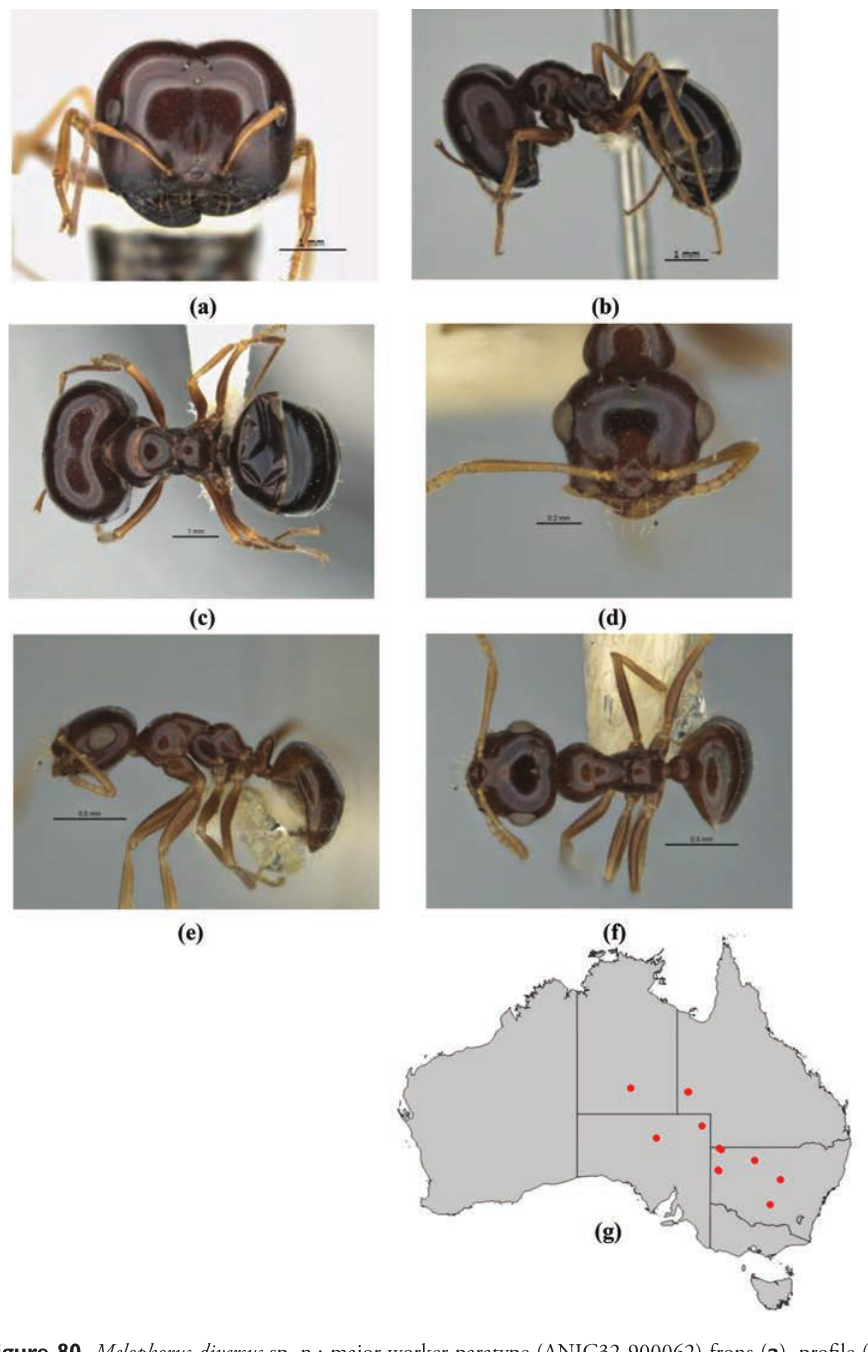
Figure 80. Melophorus diversus sp. n.: major worker paratype (ANIC32-900062) frons ( a ), profile ( b ) and dorsum ( c ); minor worker holotype (ANIC32-900186–bottom ant) frons ( d ), profile ( e ) and dor- sum ( f ); distribution map for the species ( g ). Low resolution scale bars: 1 mm ( c ); 0.5 mm ( e, f ); 0,2 ( d